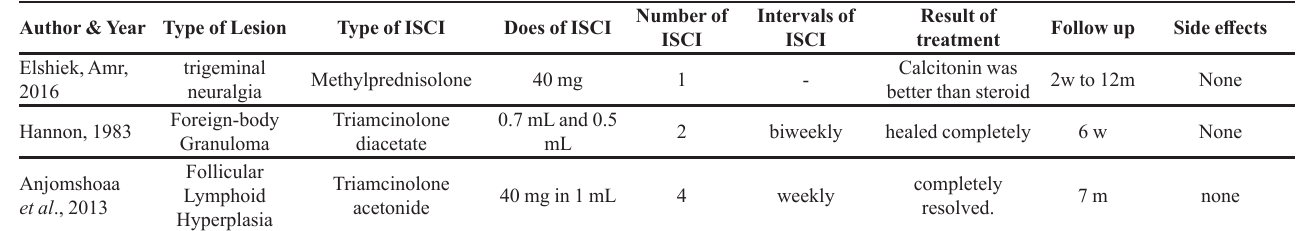
TABLE I - List of articles that applied ICSI to treatment oral lesions